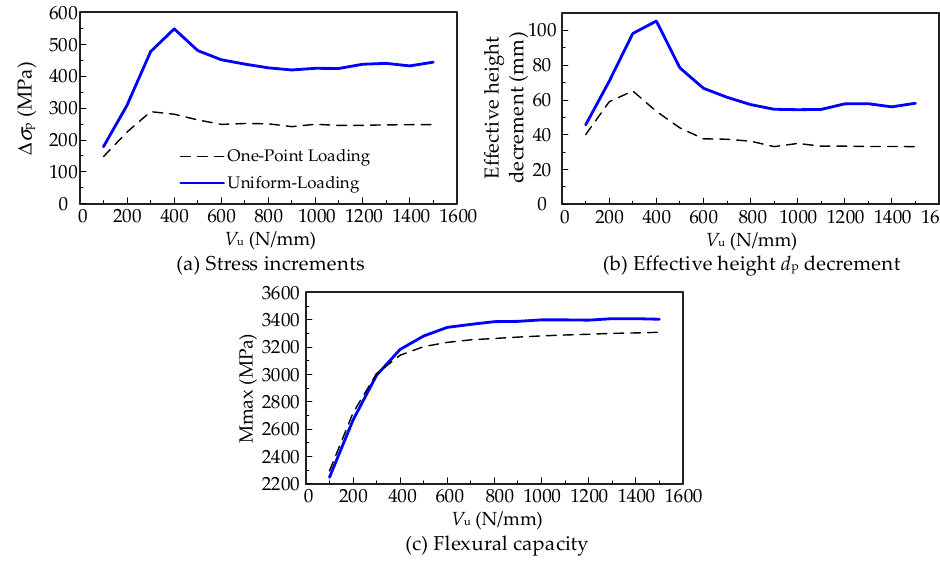
Figure 21. Effects of interfacial slip on flexural responses of EPCB.